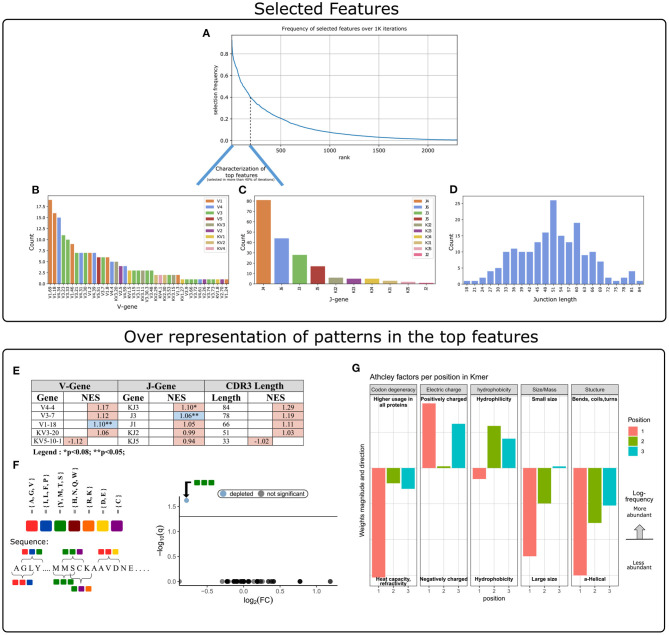
Characterization of key features used by our ML model. (A) Aggregation of feature selection outcomes. The Y-axis indicates the frequency of feature selection across 1 K subsamples, and the X-axis represents the feature rank index. (B) V gene usage within the features selected in more than 40% of subsamples. (C) J gene usage within the features selected in more than 40% of subsamples. (D) CDR3 length distribution within the features selected in more than 40% of subsamples. (E) Enrichment cluster set results. Top normalized enrichment score (NES) outcomes of three cluster set analyses (V-gene, J-gene, and CDR3-length). Colors indicate whether the FDR for multiple hypotheses is lower than 0.05, with blue for TRUE and red for FALSE. (F) Conjoint AA-triad (CT) motif is depleted in CeD-associated features. The left panel graphically displays the division of AAs to seven groups and an example representation of the possible AA-conjoint triads (as described in section 2). The right panel is a volcano plot showing the k-mer enrichment analysis with CT representation of selected clusters. The statistical significance of the difference in kmer expression plotted by the log10 q-value (FDR adjusted p-value, where q<0.05 is considered significant; horizontal line). The x-axis indicates the magnitude of the change, plotting the fold-change ratios in a log-2 scale (log2FC). The blue color indicates a point-of-interest that represents the depleted k-mer. Non-significant k-mers are shown as gray points. (G) The classifier weights for the three residue positions, provided by the MIL method (7). Columns represent the categories of five biophysicochemical factors. Positive weight values are shown as facing up bars, and negative weight values are shown as facing down bars. The length of the bar corresponds to the weight's magnitude, and the color corresponds to the position in the snippet.